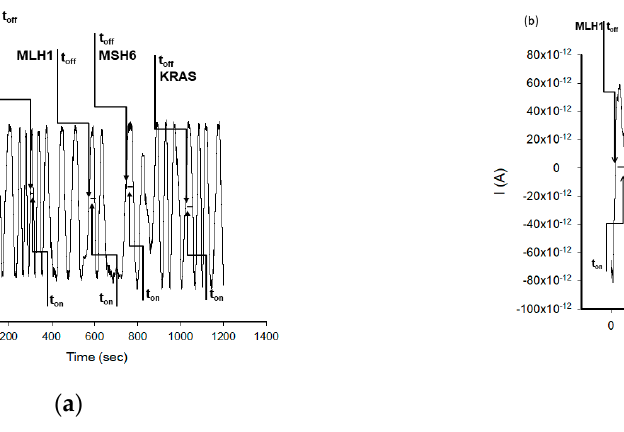
Figure 2. Examples of diagrams obtained for the screening tests of urine using the stochastic sensors based on: ( a ) MD/EGR-1 and ( b ) MD/EGR-2.